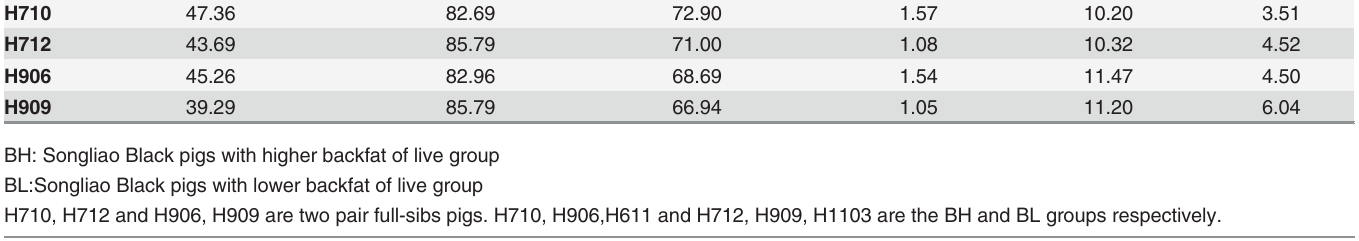
Table 1. Summary of RNA-seq alignment. Sample ID